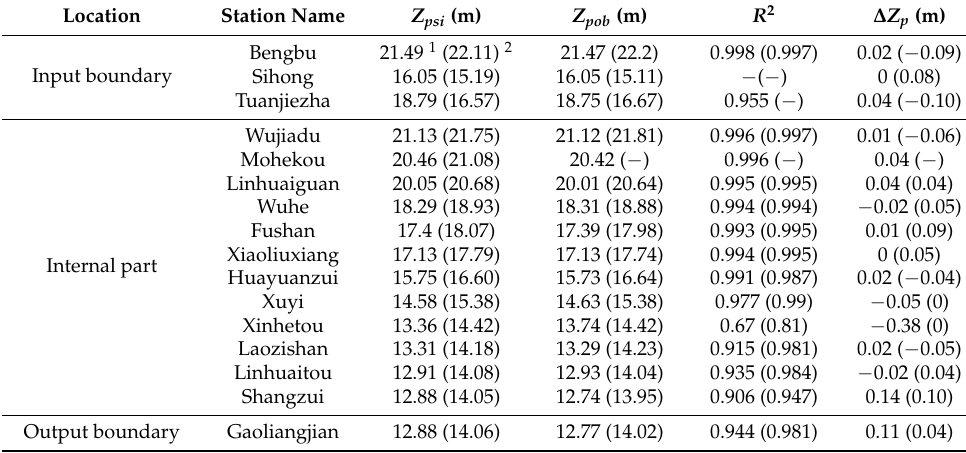
Table 2. Calibration and validation results of the DF-RMS